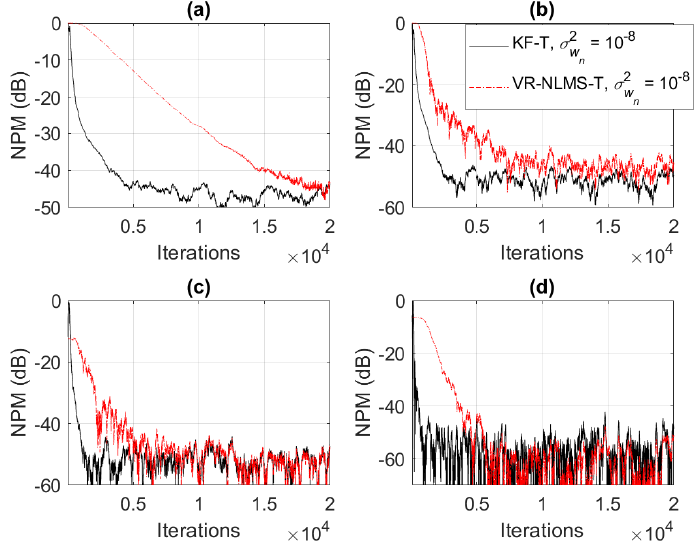
Figure 8. Normalized projection misalignment (NPM) of the KF-T and VR-NLMS-T algorithm = 10 − 8 , n = 1,2, . . . , N , for the identification of the individual impulse responses, using σ 2 w n (cid:104) (cid:105) (cid:104) (cid:105) (cid:104) (cid:105) h n ( t ) , n = 1,2, . . . , n . ( a ) NPM h 1 ( t ) , (cid:98) h 1 ( t ) h 2 ( t ) , (cid:98) h 2 ( t ) h 3 ( t ) , (cid:98) h 3 ( t ) , ( b ) NPM , ( c ) NPM , (cid:104) (cid:105) h 4 ( t ) , (cid:98) h 4 ( t ) and ( d ) NPM .